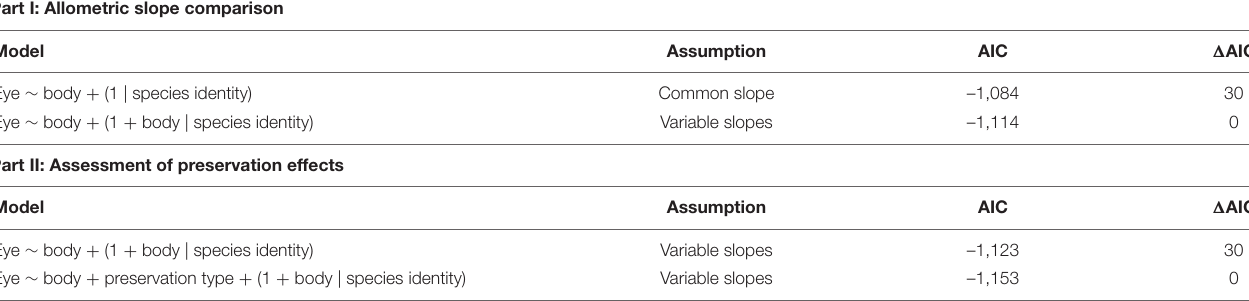
TABLE 2 | Comparison of linear mixed models of sergestid eye-body allometry using Akaike’s information criterion